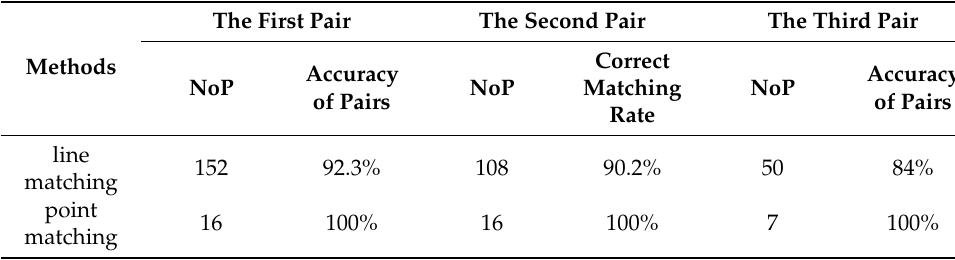
Table 1. The quantitative comparison of two matching methods.